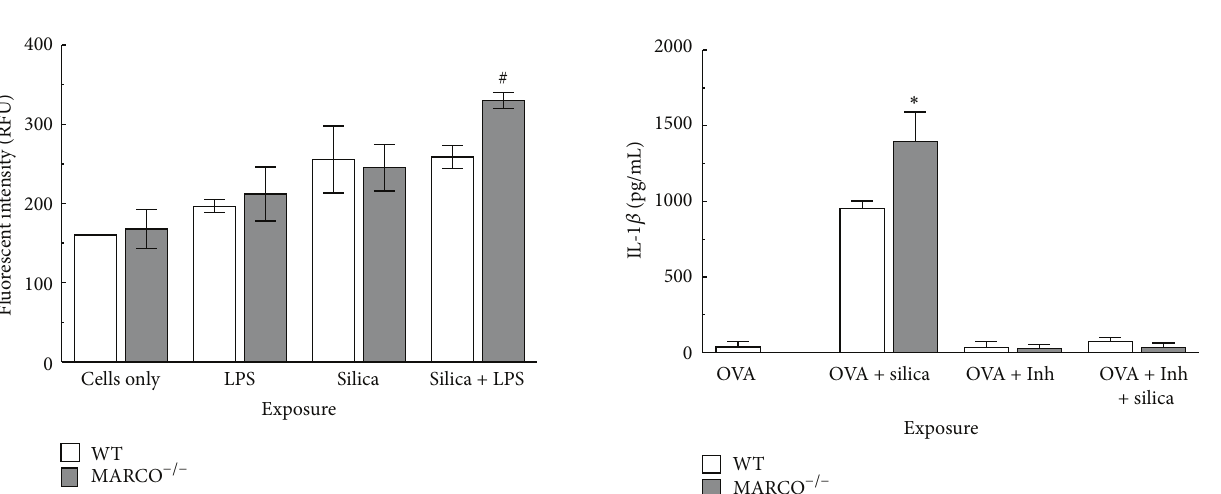
Figure 3: Effect of MARCO on NLRP3 activation using IL-1 𝛽 as an indicator and OVA as signal 1. IL-1 𝛽 release from WT and MARCO −/− AM in response to silica (100 𝜇 g/mL) cocultured with OVA (10mg/mL) and with or without cathepsin B inhibitor (10 𝜇 M CA-074-Me). Mean ± SEM IL-1 𝛽 from cultured macrophages where white bars indicate WT AM and grey bars indicate MARCO −/− AM. Asterisk ∗ indicates 𝑃 < 0.05 compared to WT, 𝑛 = 3 per experimental